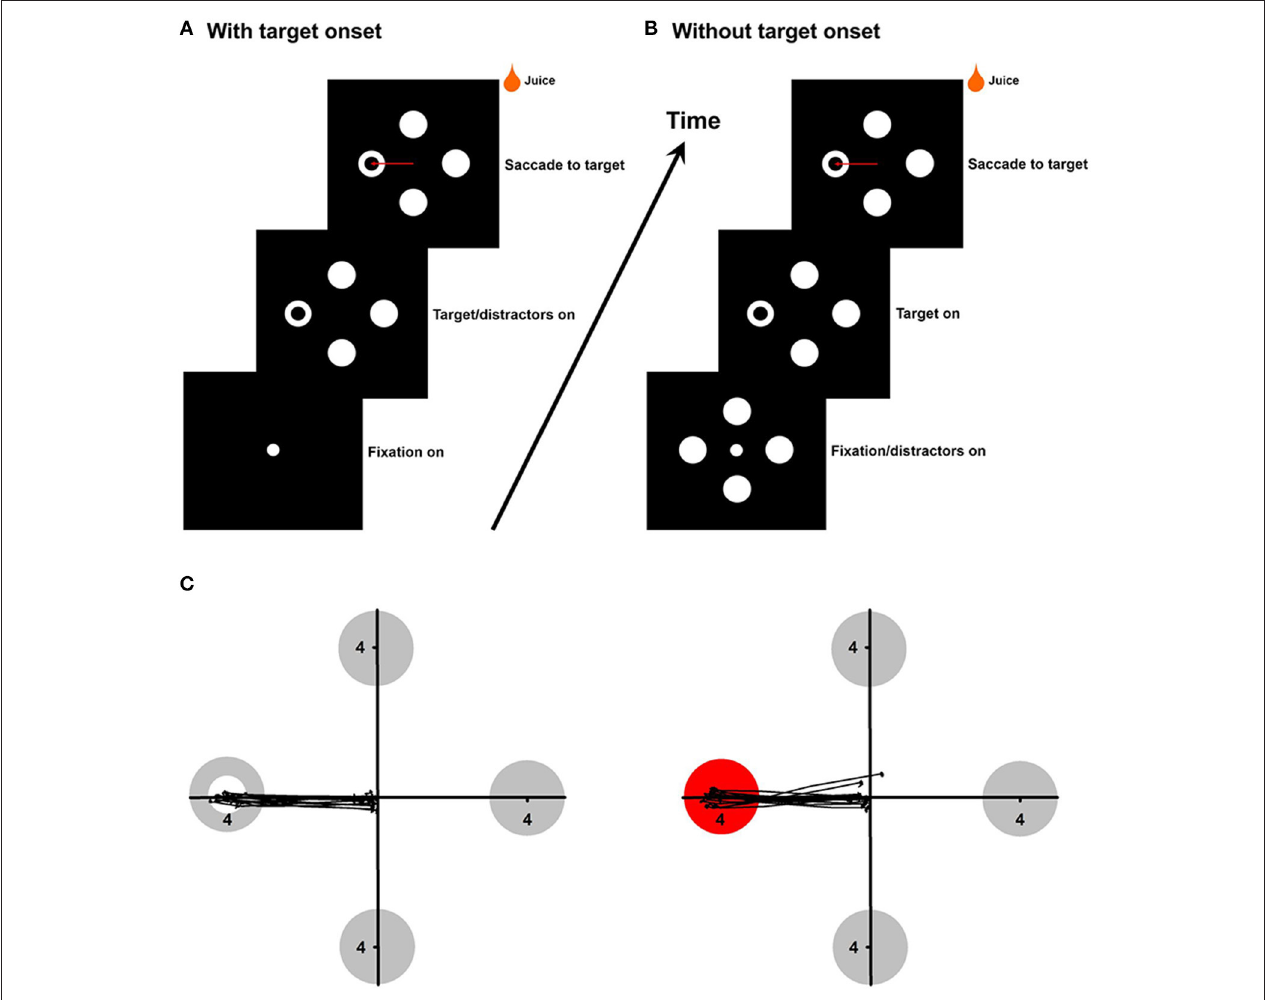
FIGURE 1 | (A,B) , Experimental paradigms in the with-onset and without-onset conditions. (C) Saccade trajectories to the ring target (left panel) and the red circle target (right panel). Each black line represents one saccade trajectory.